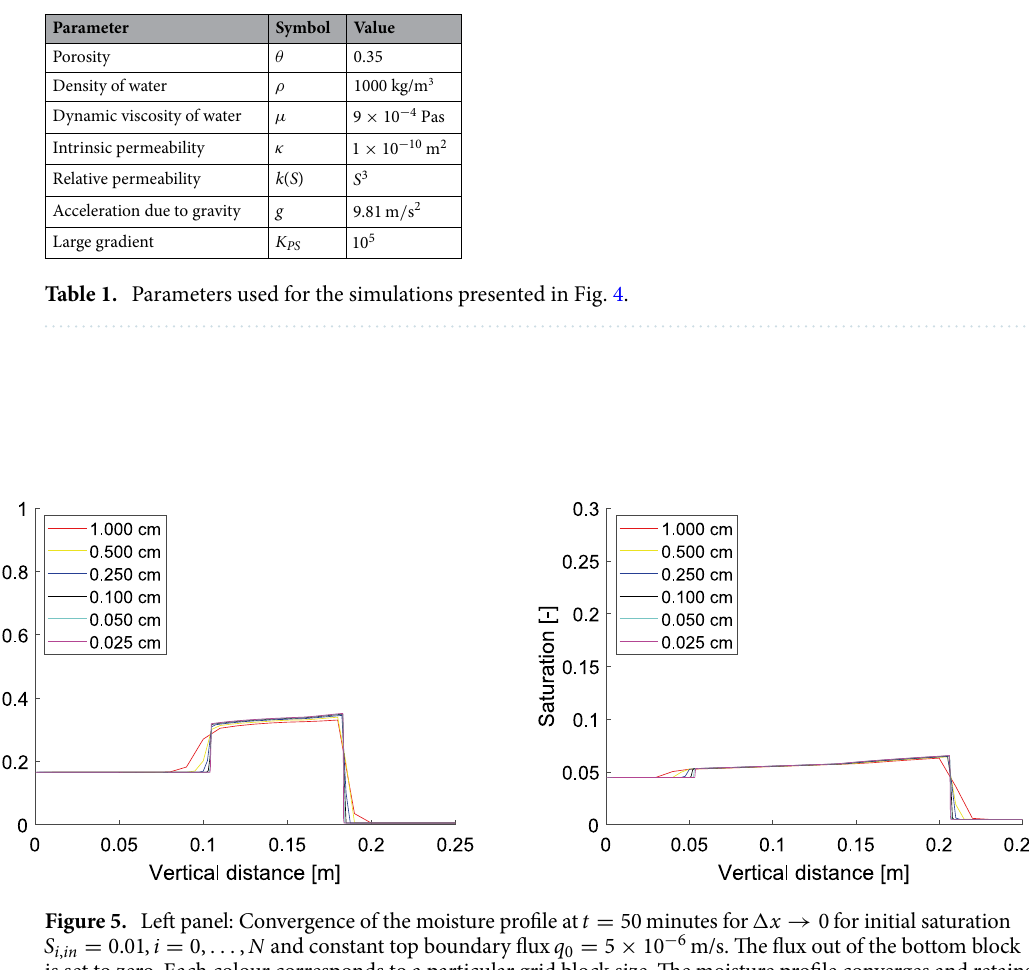
Figure 5. Left panel: Convergence of the moisture profile at t 0.01 , i 0, . . . , N and constant top boundary flux q 0 S i , in = = is set to zero. Each colour corresponds to a particular grid block size. The moisture profile converges and retains the overshoot pattern. Right panel: Convergence of the moisture profile at t 0.14 , i 0, . . . , N and constant top boundary flux q 0 initial saturation S i , in = = the bottom block is set to zero. Each colour corresponds to a particular grid block size. A smaller y -axis scale is used to show the details of the moisture profiles. The moisture profile converges and retains the overshoot